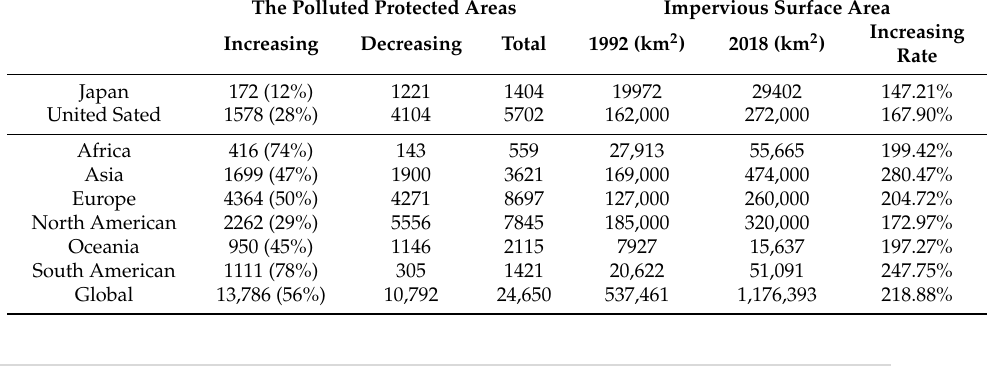
Table 3. Statistics of polluted PAs and impervious surface area across different regions.